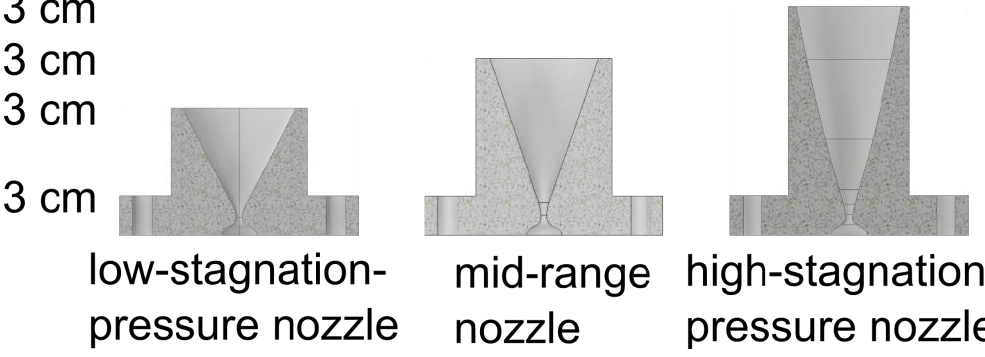
Figure 3. Cross sectional profiles of the characterized nozzles. The base and the diameter of the hole are identical for every nozzle.